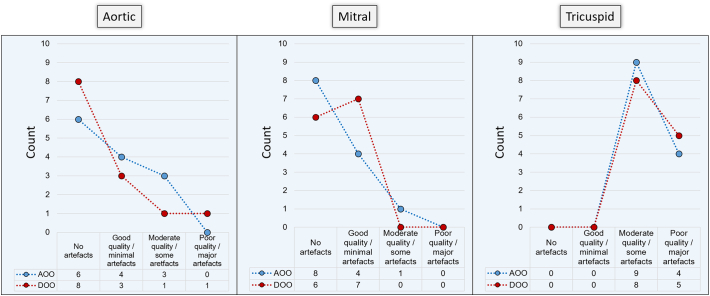
Qualitative assessment of flow in the raw data prior to valvular plane reconstruction.Even though poor quality for tricuspid flow was more often noted, by removing the miscalculated pixels, we were able to quantify tricuspid stroke volume.